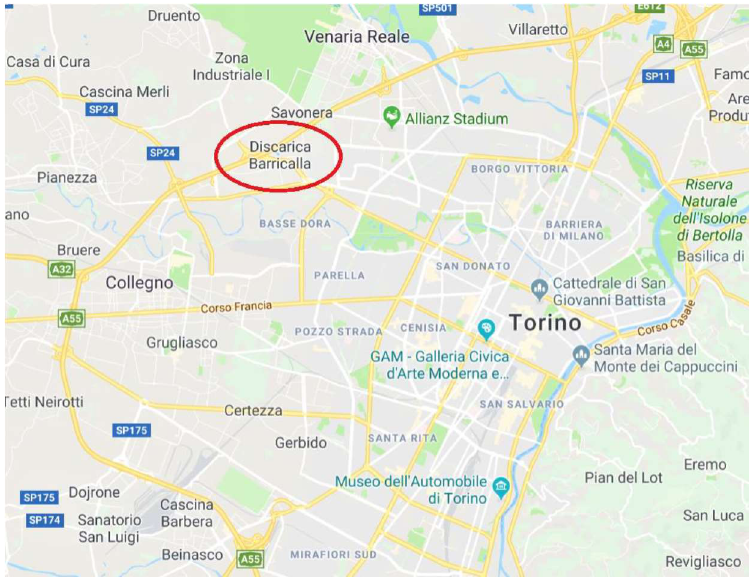
Figure 2. Location of the Barricalla landfill.